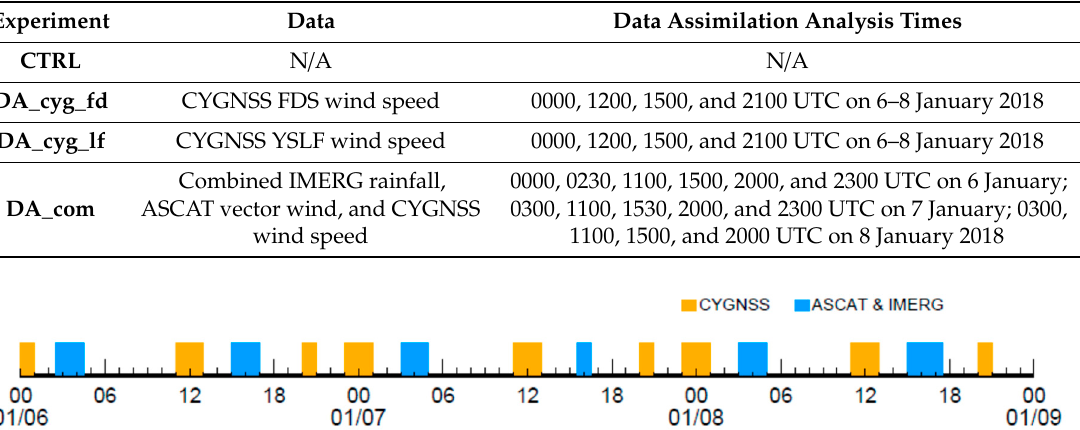
Figure 3. Data assimilation process for the experiment DA_com. Orange boxes show the time windows for CYGNSS data assimilation, and the blue boxes show the time windows when the ASCAT and IMERG data were assimilated. In the time window near 1500 UTC of each day, all three types of data were assimilated.